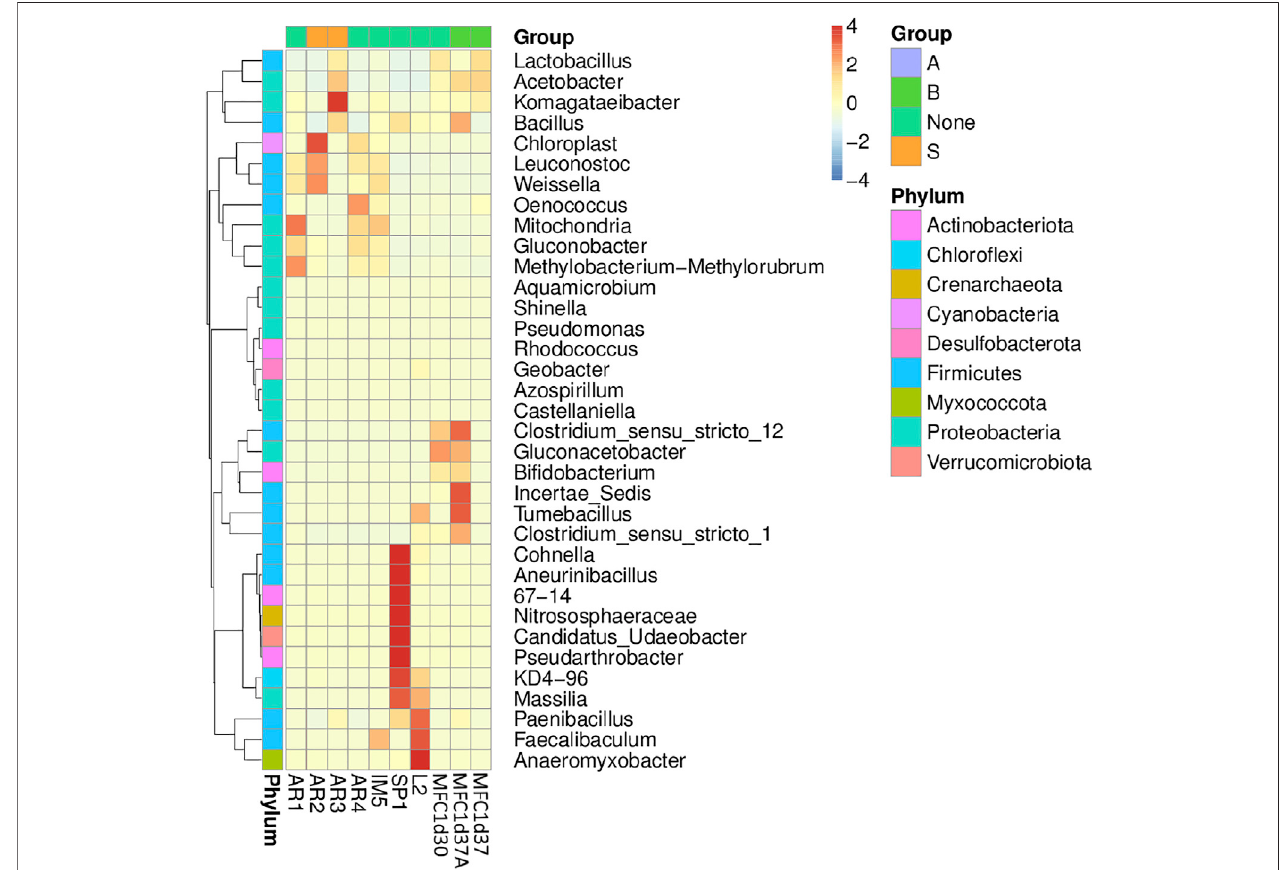
FIGURE 11 | Heat map with the bacterial genera of the samples of the native microbial communities and from the anode of MFCs, as described in Figure 10 .